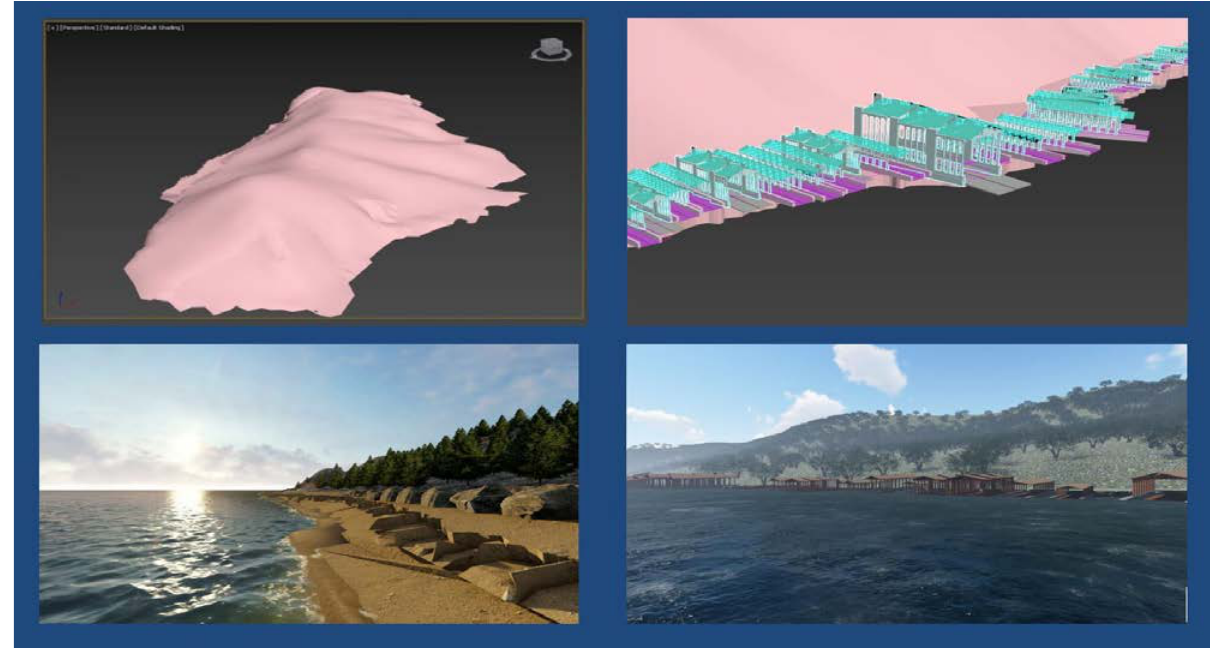
Figure 10 The steps taken from photogrammetric model to 3D